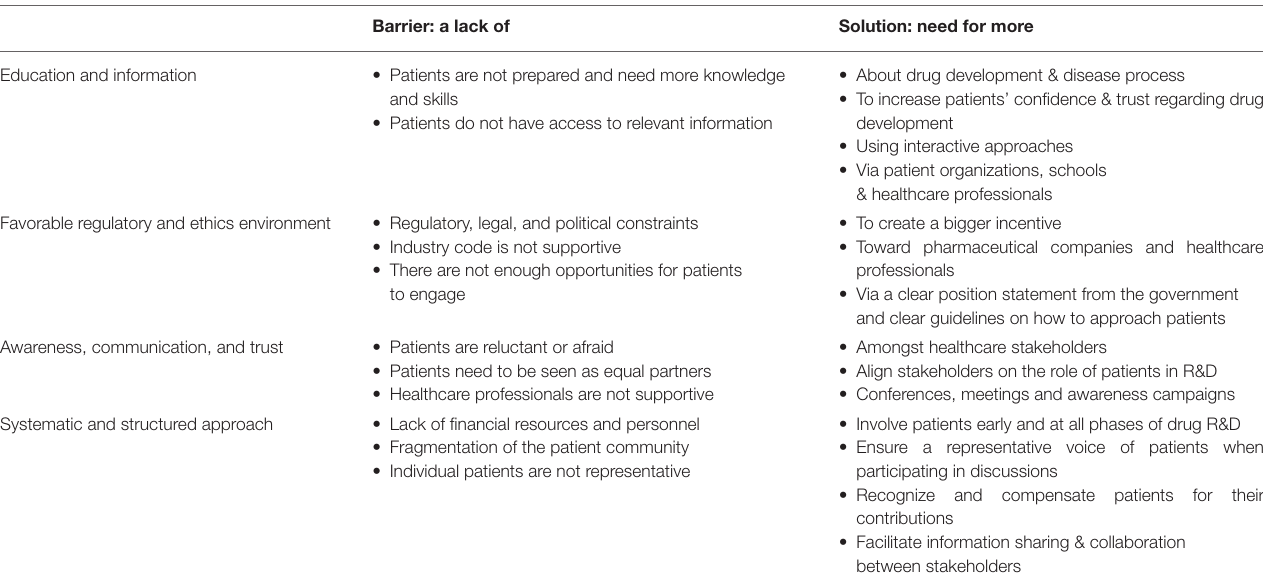
TABLE 4 | Barriers and solutions proposed by the respondents. Barrier: a lack of Solution: need for